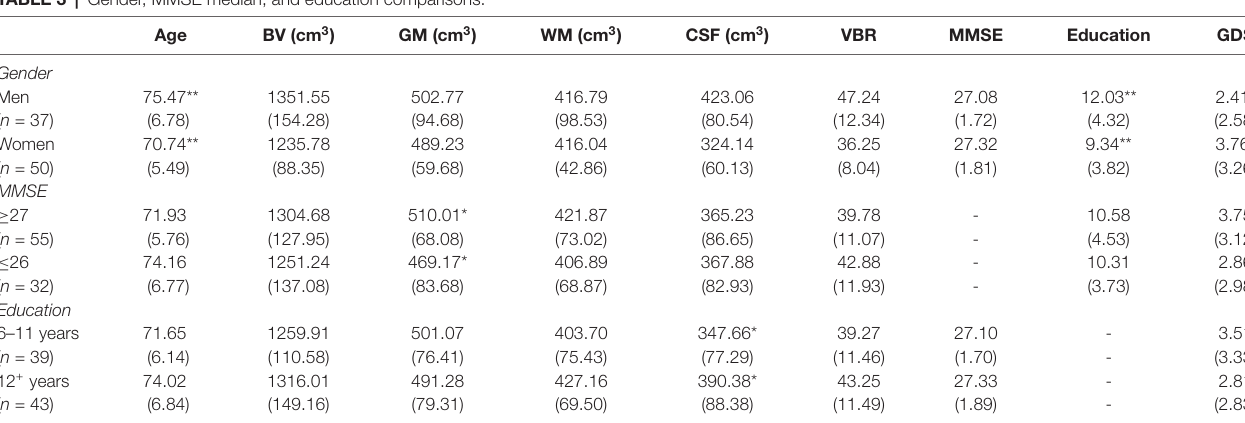
TABLE 3 | Gender, MMSE median, and education comparisons.